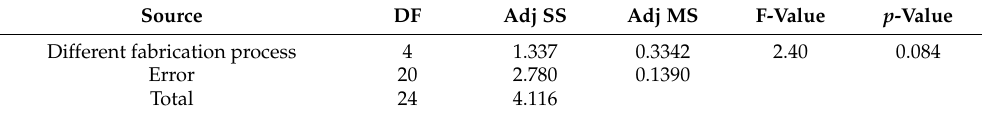
Table 2. Results of the one-way ANOVA for Sa with respect to the different fabrication